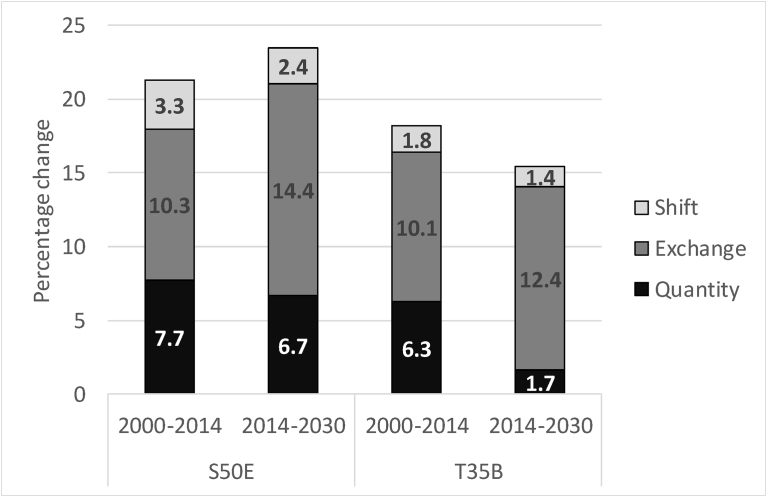
Disagreement budget.